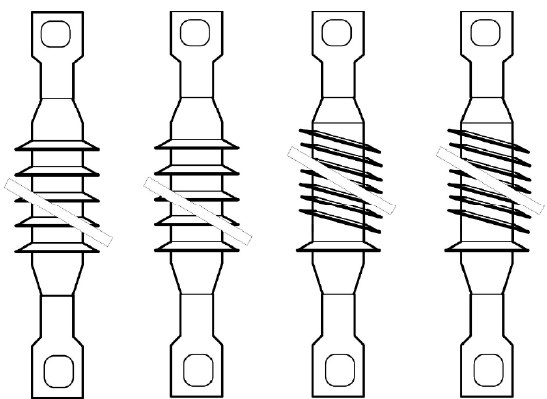
Fig. 15. Polymer-composite insulators: Long-rod- type (Redrawn and adapted figure from